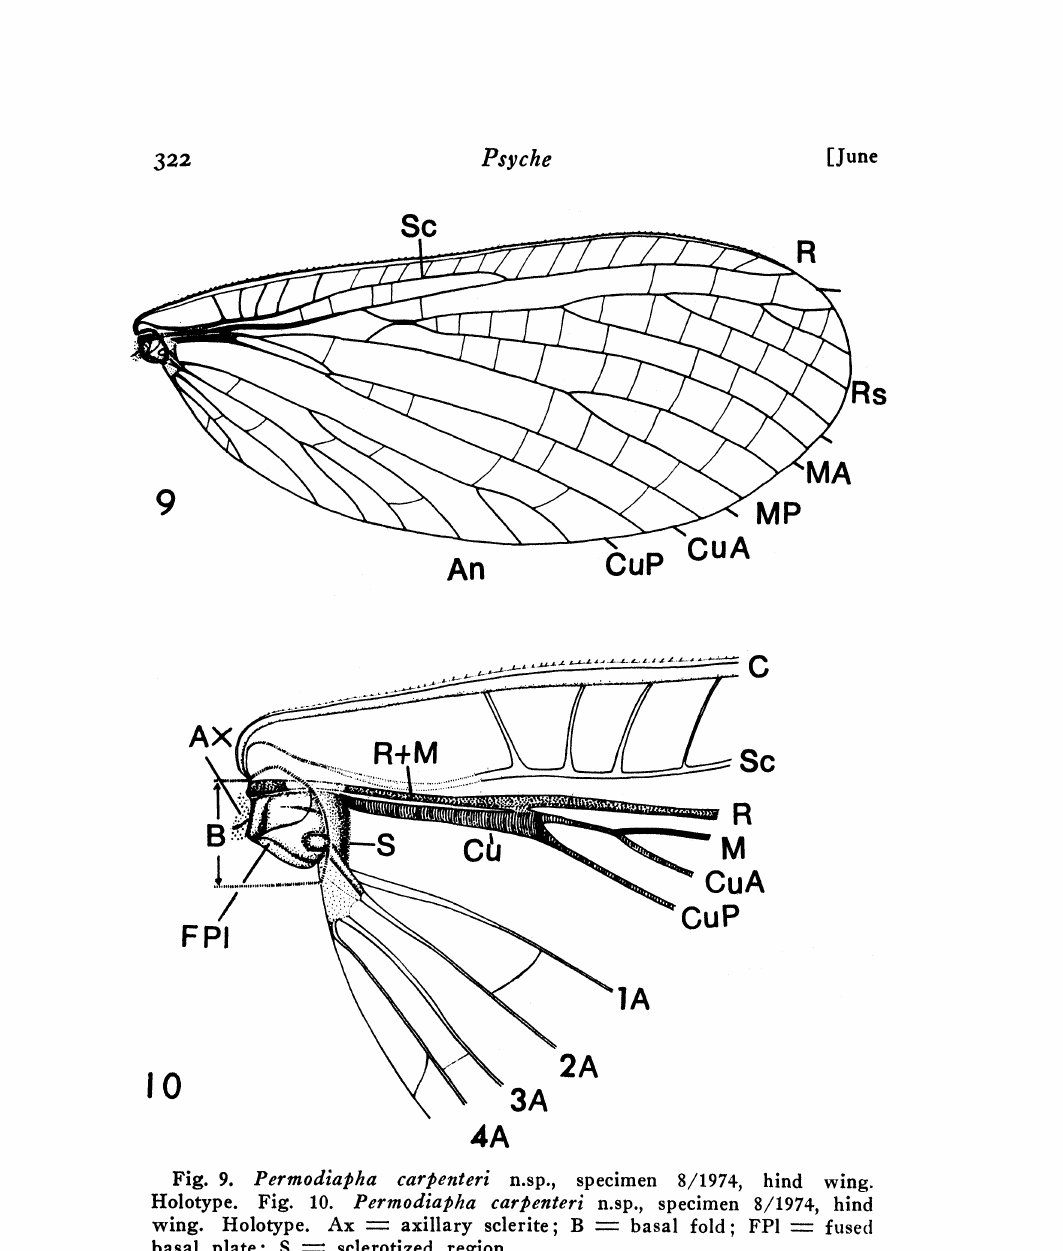
Fig. 9. Permodialha carenteri n.sp., specimen 8/1974, hind wing. Holotype. Fig. 10. Permodialha car#enteri n.sp., specimen 8/1974, hind wing. Holotype.